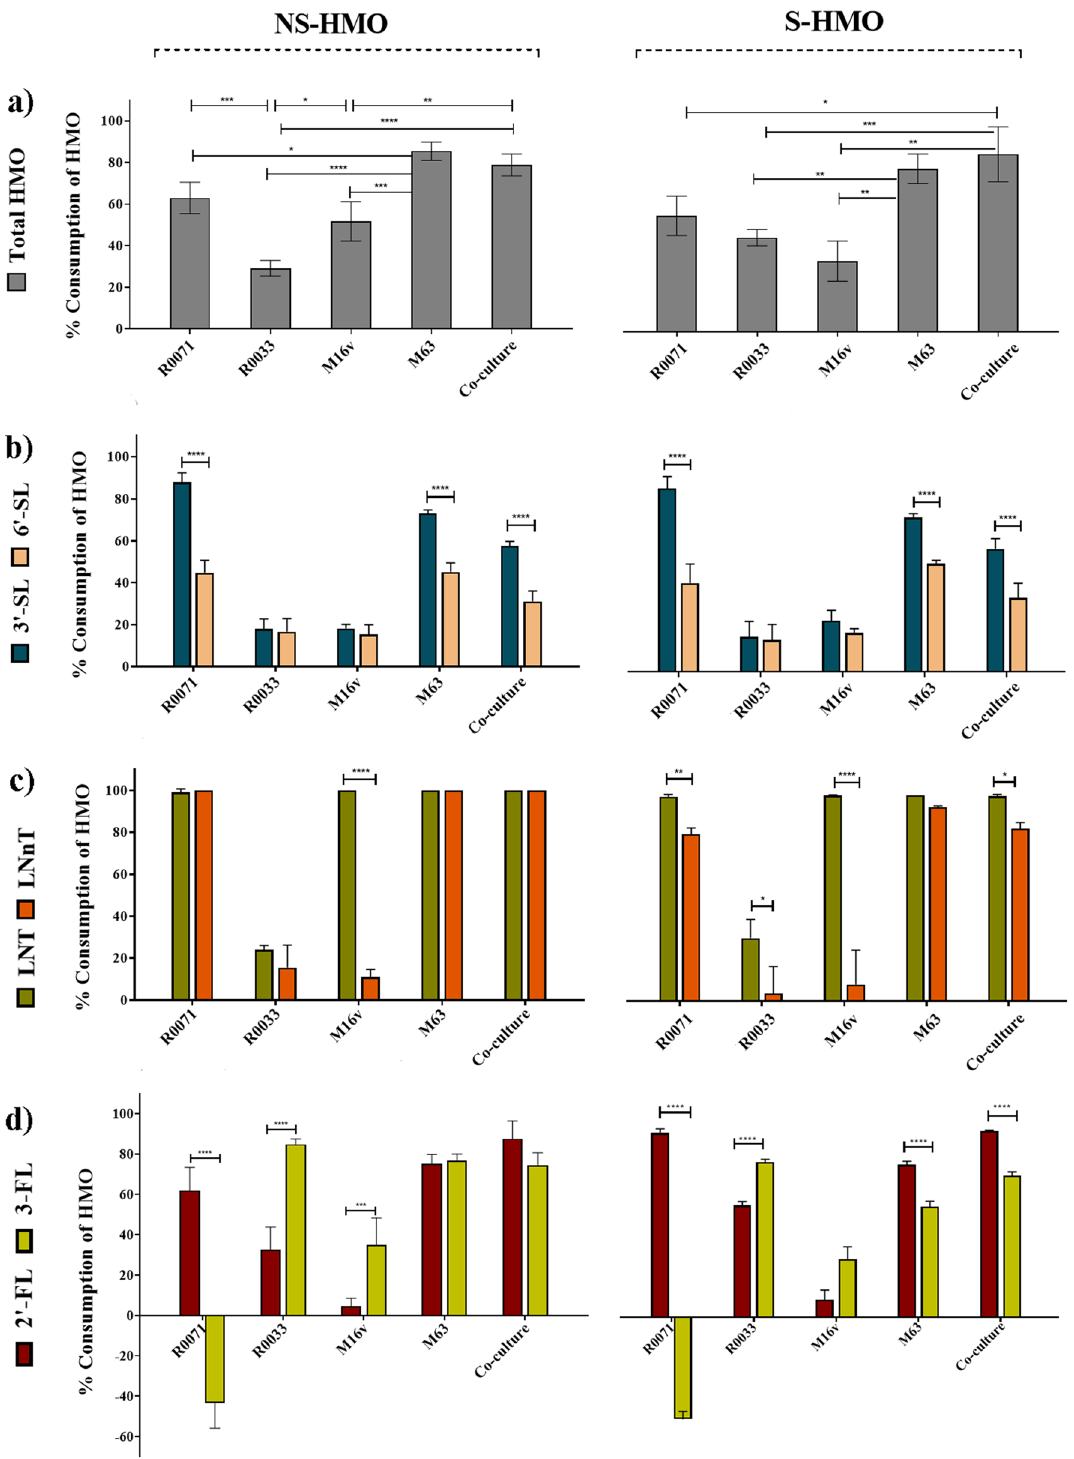
Figure 2. Percentage consumption of oligosaccharides after 10 h of bifidobacterial fermentation on a model of NS-HMO and S-HMO versus the uninoculated control. The concentrations of oligosaccharide in culture were determined by HPAEC-PAD. The eluted sugars were identified from their elution times relative to those of external standards (lactose, 3-fucosyllactose [3-FL], 2 ′ -fucosyllactose [2 ′ -FL], lacto- N -neotetraose [LNnT], lacto- N -neohexaose [LNnH], lacto- N -tetraose [LNT], lacto- N -hexaose [LNH], sialic acid, sialyllacto- N -tetraose a [LSTa], sialyllacto- N -tetraose c [LSTc], 6 ′ -siallylactose [6 ′ -SL], 3 ′ -siallylactose [3 ′ -SL], disialyllacto- N -tetraose [DSLNT]) ( a ) Consumption of total HMO, ( b ) Consumption of the siallylactoses, 3 ′ -SL and 6’-SL, ( c ) Consumption of the tetraoses, LNT and LNnT and ( d ) Consumption of the fucosyllactoses, 2 ′ -FL and 3-FL. R0071 = Bifidobacterium bifidum R0071, R0033 = Bifidobacterium infantis R0033, M-16V = Bifidobacterium breve M-16V, M-63 = Bifidobacterium infantis M-63. Analysis was calculated using technical duplicate data from biological triplicate experiments and data are means + /− SD. Univariate analysis of variance (ANOVA) and post-hoc Tukey tests were performed to determine the significant differences between the groups (* = p < 0.05, ** = p < 0.01, *** = p < 0.001, **** = p <